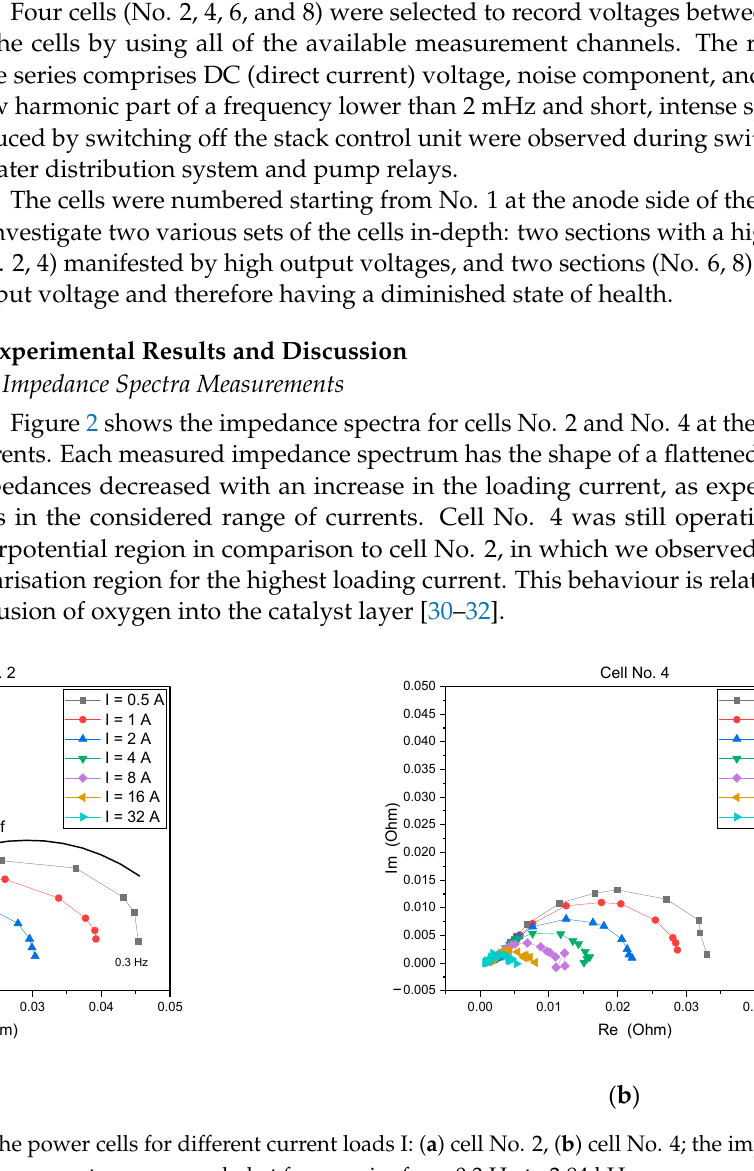
Figure 1. Schematic diagram of the applied test stand.